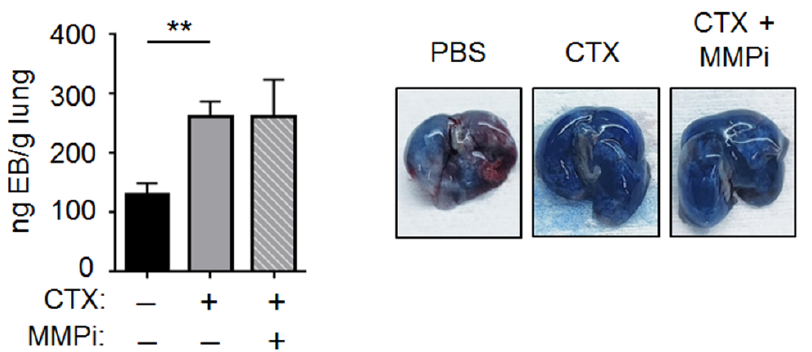
Figure 5. CTX increased vascular permeability in the lung. Left : Mice were pre-treated with CTX (+) or vehicle ( − ), and 4 days later their vascular permeability in the lung was assayed by Evans blue (EB) dye as detailed in Materials and Methods. When indicated, MMPi was injected 24 and 72 h after CTX treatment. After removing intravascular EB by perfusion, EB in the lung parenchyma was extracted by formamide and the nanogram (ng) EB per gram (g) of dried lung was determined as described in Materials and Methods ( n = 4–8 from 2 independent experiments). Right : Representative images. Bars indicate mean ± SEM; one-way ANOVA with post hoc Holm–Š í d á k correction; ** p <